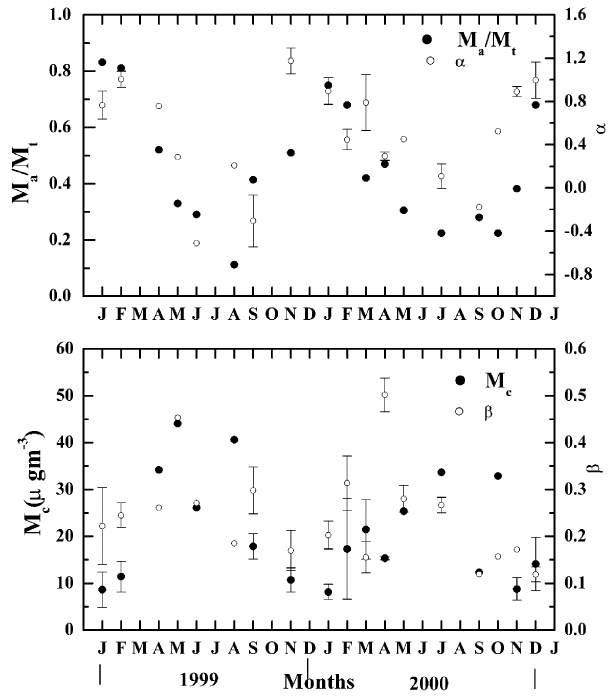
Fig. 2. Annual variation of ˚Angstr¨om parameters, α along with the ratio of accumulation mode aerosol to total aerosol mass concen- tration (top panel), and β along with the coarse mode aerosol mass concentration (M t ) (bottom